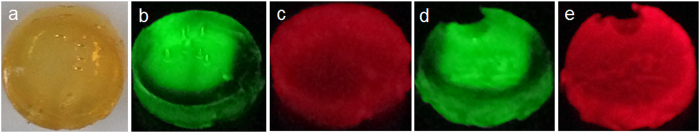
(a) BSA hydrogel under normal white light;(b) BSA hydrogel image (excited at 470 nm) is collected using a λ = 530 nm optical filter; (c) BSA hydrogel image (excited at 595 nm) is collected using a λ = 630 nm optical filter. (d) HSA hydrogel image (excited at 470 nm) is collected using a λ = 530 nm optical filter. (e) HAS hydrogel image (excited at 595 nm) is collected using a λ = 630nm optical filter.